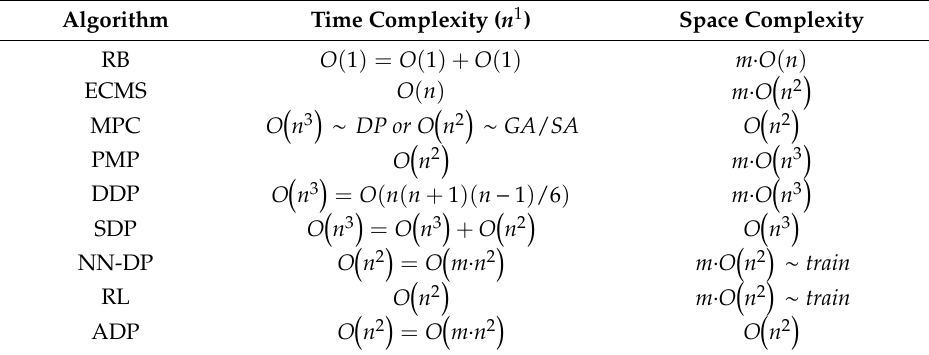
Table 2. The complexity of the above-mentioned